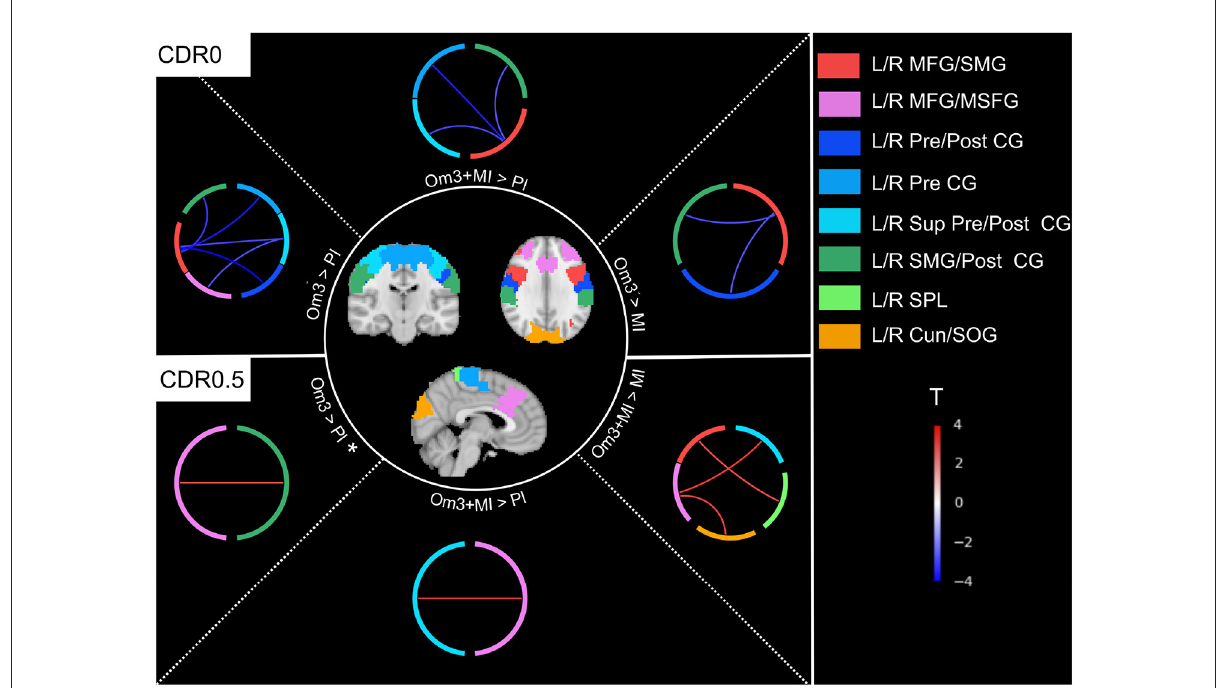
FIGURE2 Connections showing a difference over the evolution of FC between interventions within each subgroup of baseline CDR0 and CDR0.5 (Table 3). Almost all connections were significant except for the L/R MFG/MSFG - L/R SMG/Post CG connection for the comparison CDR0.5 Om3 > Pl that was close to significance ( p < 0.06)*. Om3 + MI, Omega-3 fatty acid supplementation and multidomain intervention; Om3, omega-3 fatty acid supplementation; MI, multidomain intervention; Pl, placebo; L/R Cun/SOG, left/right cuneus/superior occipital gyrus (visual network); L/R MFG/MSFG, left/right middle frontal gyrus/superior frontal gyrus medial segment (frontoparietal network); L/R SMG/Post CG, left/right supramarginal gyrus/post central gyrus (salience network); L/R MFG/SMG, left/right middle frontal gyrus/supramarginal gyrus (frontoparietal network); L/R Pre CG, left/right pre central gyrus (sensorimotor network); L/R Sup Pre/Post CG, left/right superior pre/post central gyrus (sensorimotor network); L/R Pre/Post CG, left/right pre/post central gyrus (sensorimotor network); L/R SPL, left/right superior parietal lobule (salience network); T , t -value for post hoc tests (Table 3), red connections represent a positive difference between mean connectivity of interventions group with omega-3 fatty acid supplementation vs. no omega-3 fatty acid supplementation, blue connections represent a negative